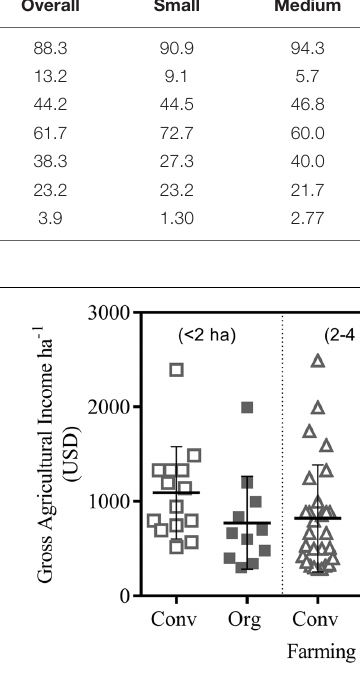
TABLE 1 | Profile of surveyed respondents for gender, age, education, farming experience and land holding. Farming practices Conventional Organic Small Medium Large Overall Small Medium Large Overall